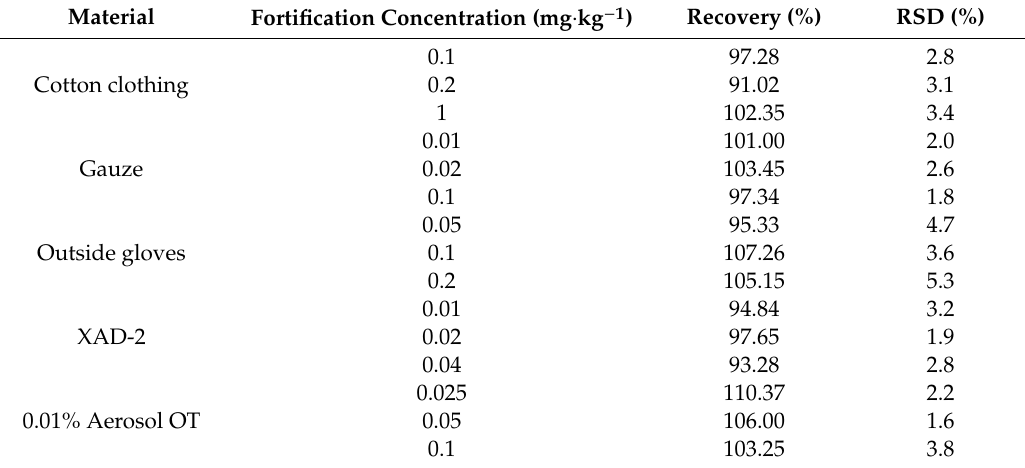
Table 1. SYP-9625 recovery from field-fortified